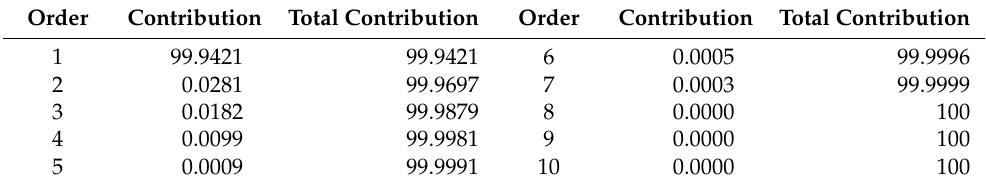
Table 2. Contribution of each order.